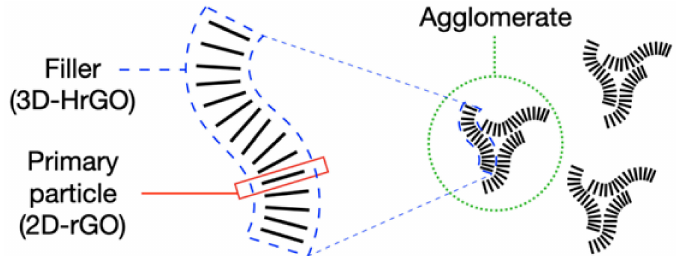
Figure 3. Schematic illustration of the three structural levels that comprise the morphology of HrGO nanocomposites: primary particle, filler and